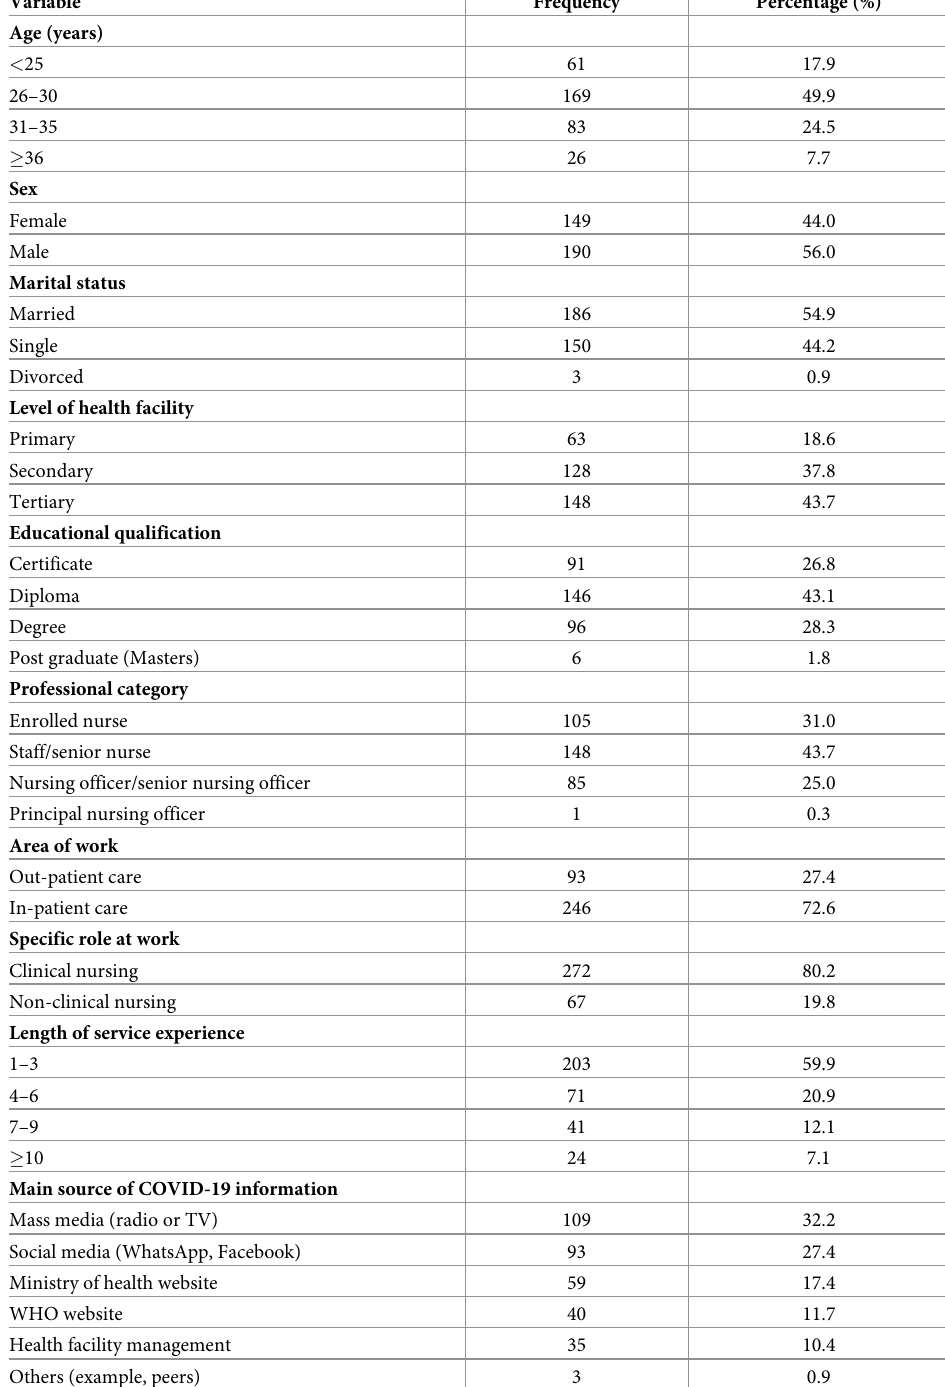
Table 1. Socio-demographic characteristics of nurses included in the study (n =